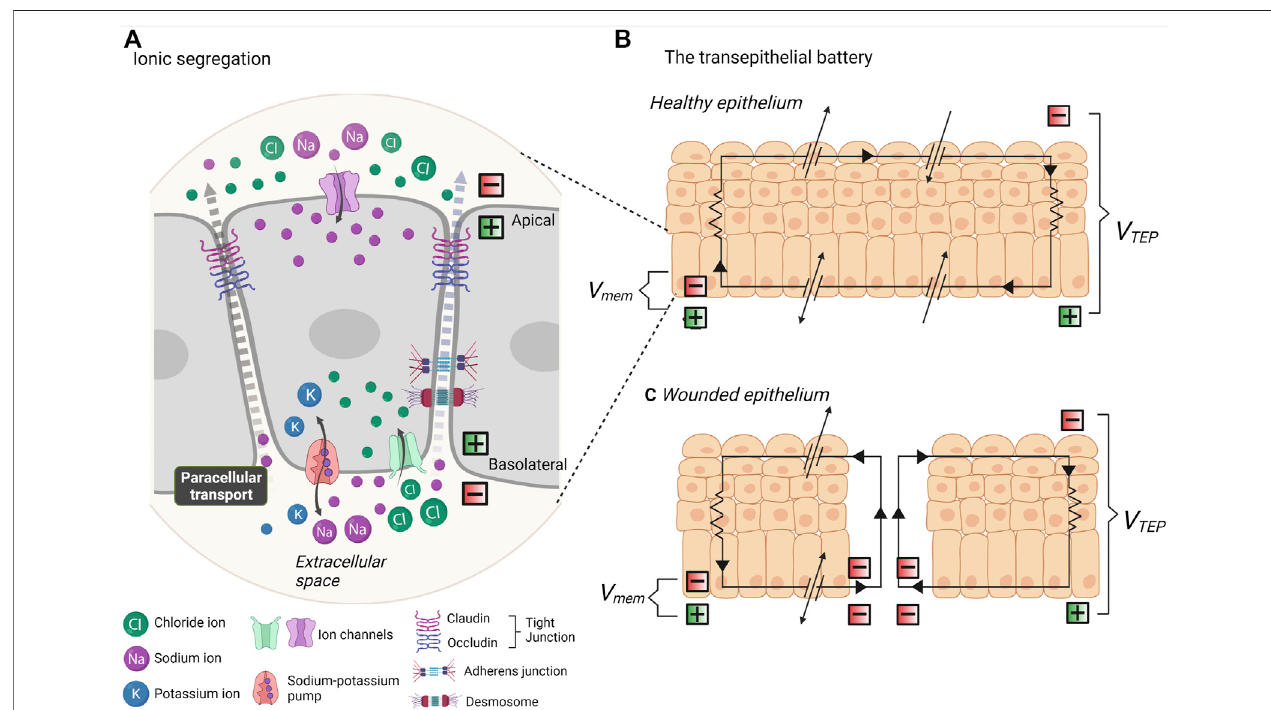
FIGURE 2 | Endogenous electrical fi elds and the transepithelial battery. (A) In vivo , all cells exhibit a resting membrane potential due to the segregation of ionic charges. Ion transport channels are asymmetrically distributed across apical and basal membranes. Ion fl ux occurs transcellularly and ions are selectively transported acrosstheplasmamembrane,whilstparacellulartransport(betweencells)mustworkagainsttheresistanceoftightjunctions,adherensjunctionsanddesmosomes. (B) The segregation of ionic charges creates a difference in membrane potential (Vmem) at each apical-basal membrane. All of the segregated chargers in epithelia amounttoatransepithelialpotentialdifference(VTEP). (C) Whentheepitheliumisbreached,theVTEPdropsandioniccurrent fl owsoutfromthesiteofwound.Thus,the epithelial works as a battery to mediate wound repair.